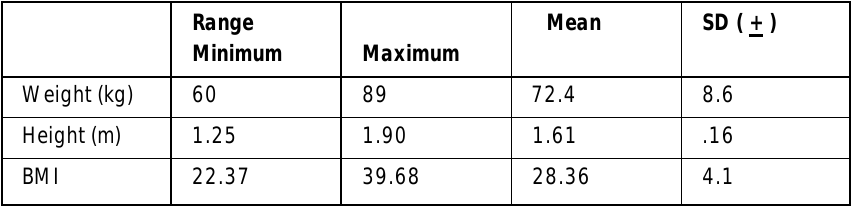
Table 3: Ranges, Means and Standard Deviations of Anthropometric Characteristics (N=27)